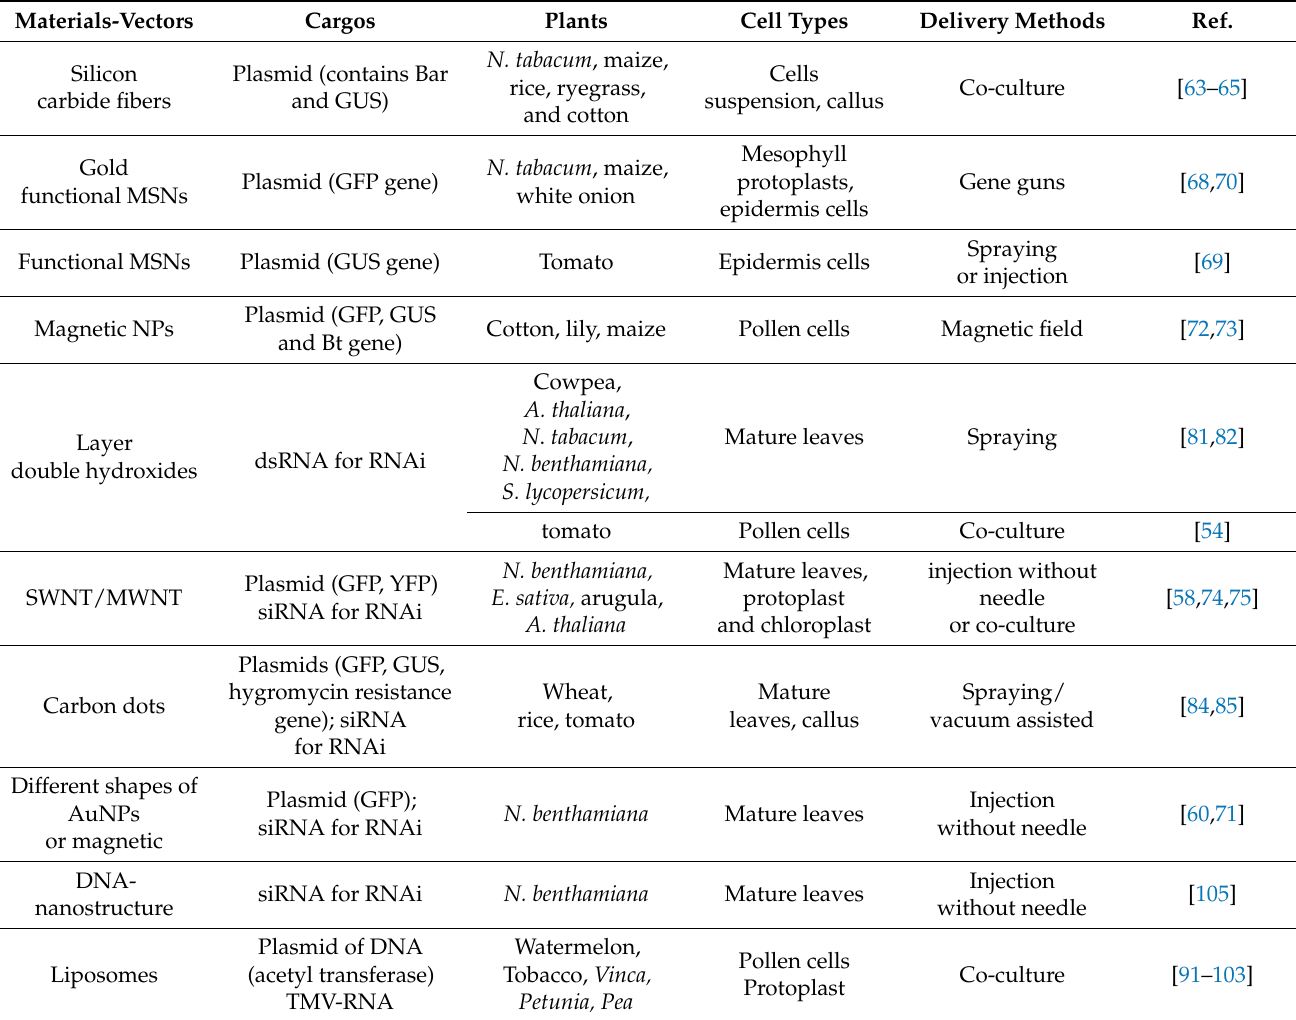
Table 2. Summary of the micro/nanovectors for plants in recent